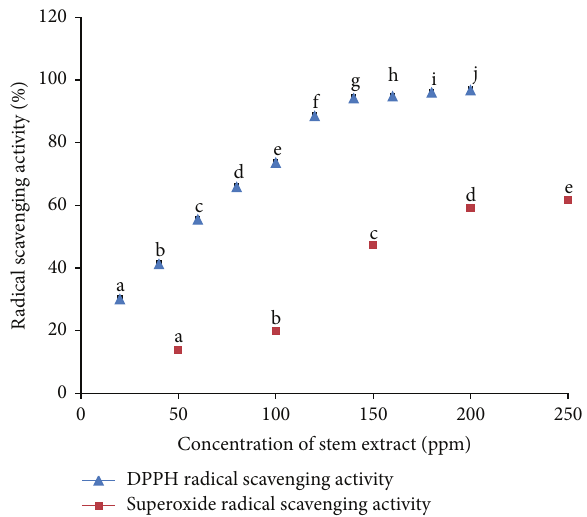
Figure 1: DPPH free radical and superoxide anion radical scav- enging activities of stem of Plectranthus amboinicus at different concentrations. Values followed by different letters are significantly different ( 𝑃 < 0.05 ) from each other in each assay.